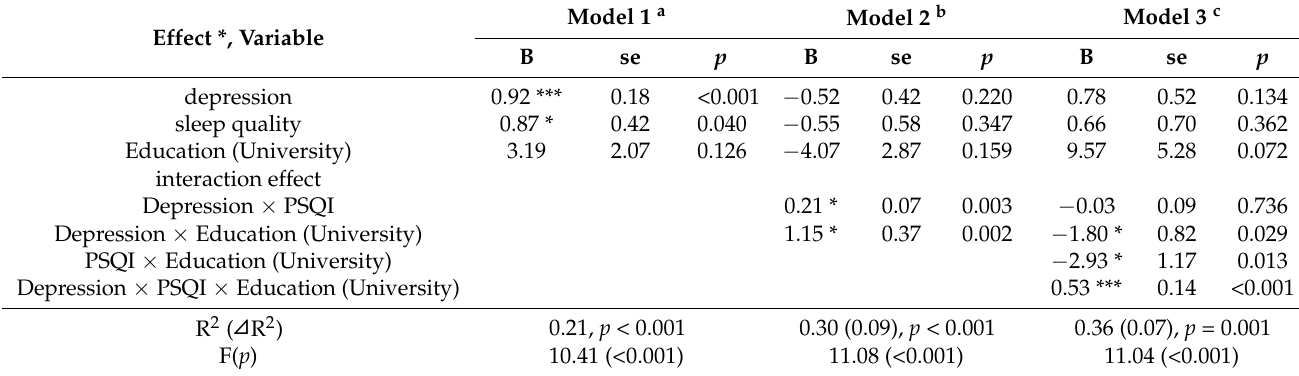
Table 3. Moderated moderation effect of sleep quality and education level between depression and suicidal ideations.